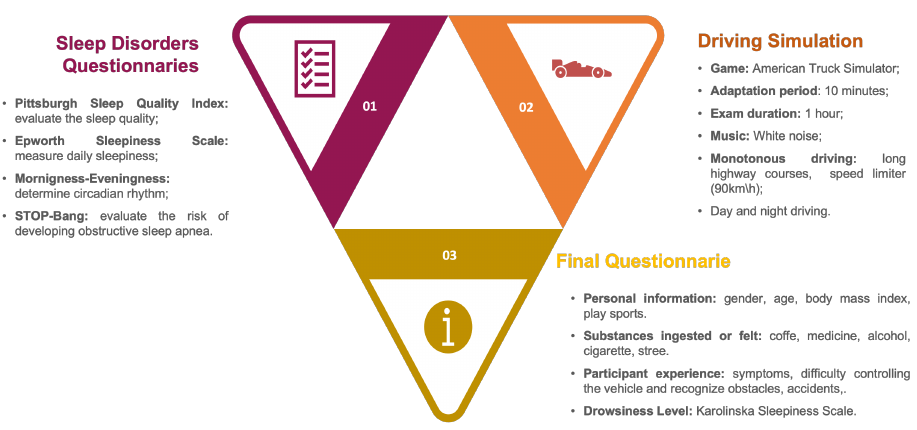
Figure 1. Driving Simulation